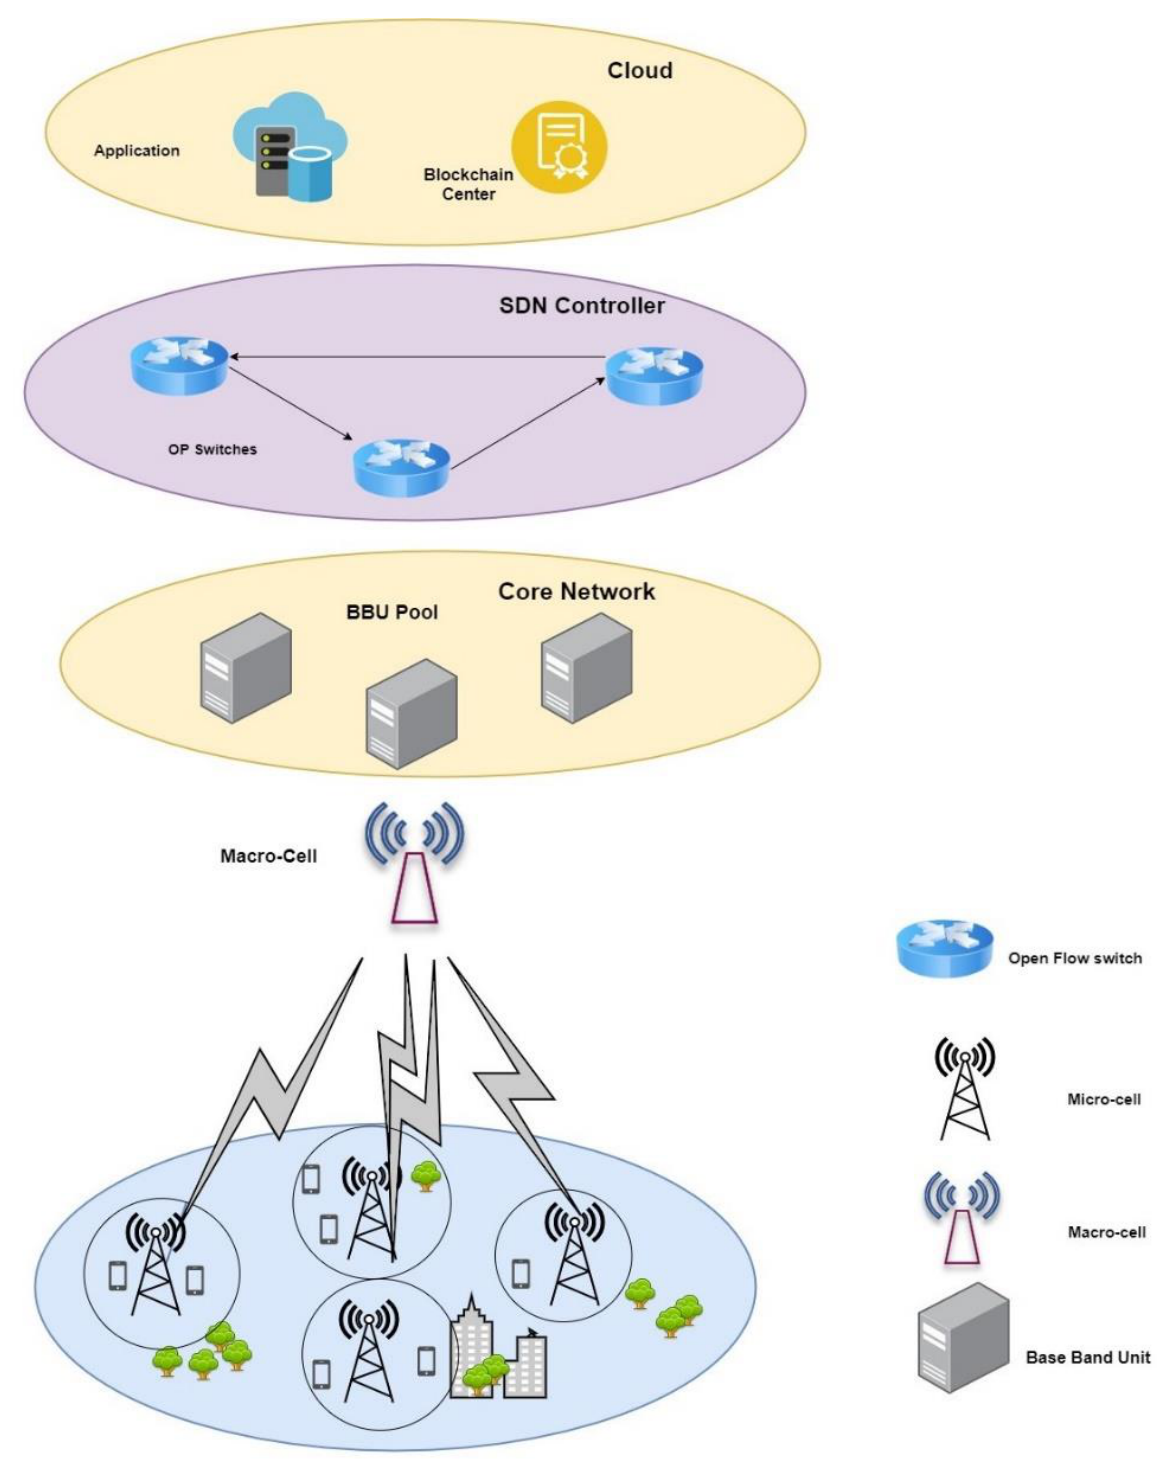
Figure 1. C-RAN enabled SDN